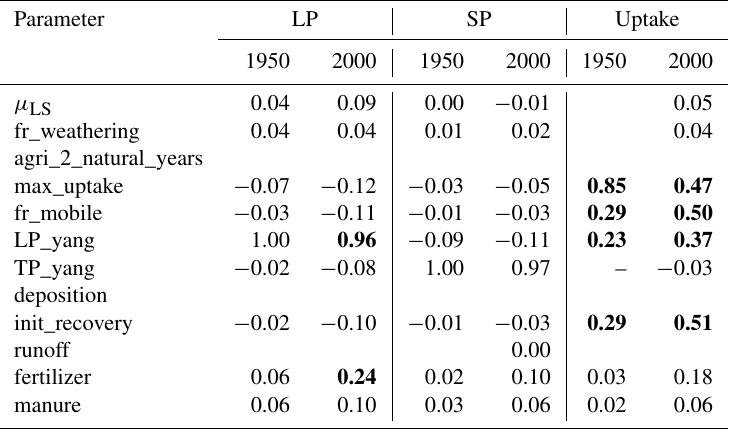
Table 4. Standardized regression coefficient (SRC) a representing the relative sensitivity of the soil LP, SP pools, and crop P uptake to the variation of 12 model parameters. Columns values represent the global model results for the year 1950s and 2000. Parameter LP SP Uptake